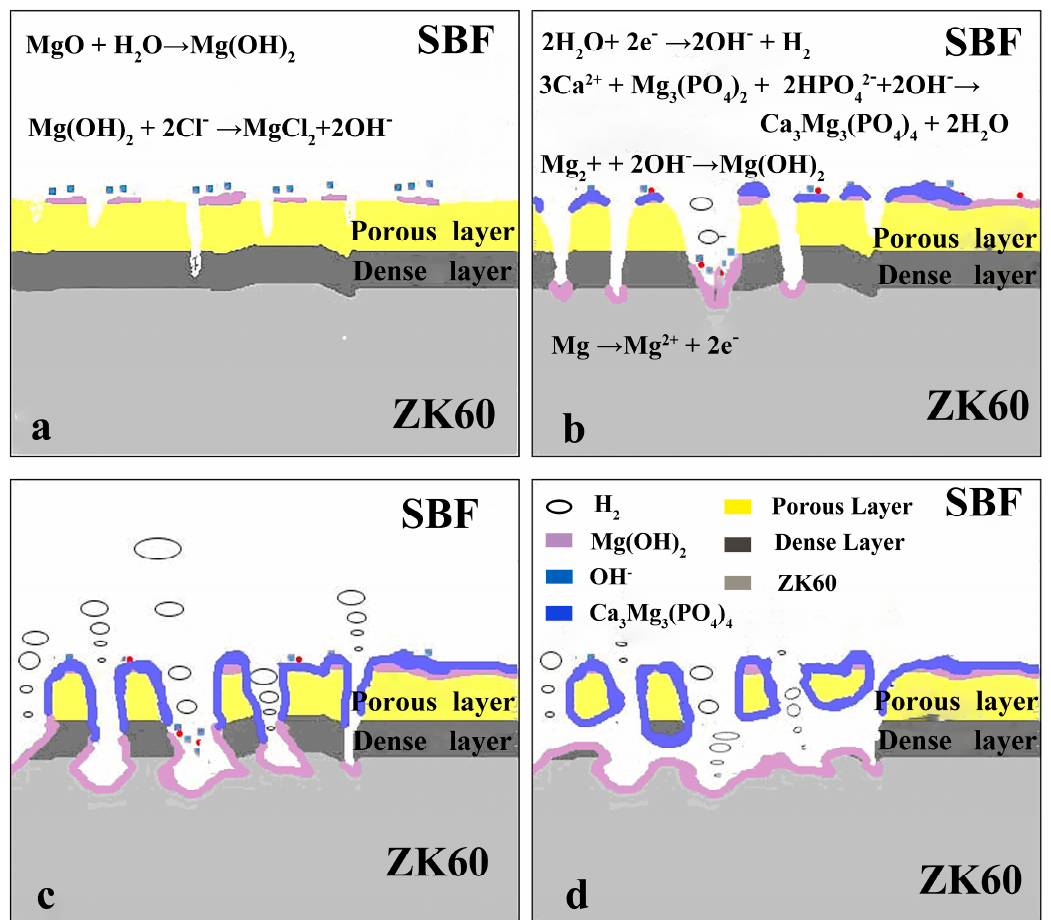
Figure 13. Degradation models of the MAO coated samples upon immersion in the SBF: ( a ) surface corrosion stage, ( b ) micro-pore enlargement stage, ( c ) coating degradation stage, and ( d ) coating decomposition